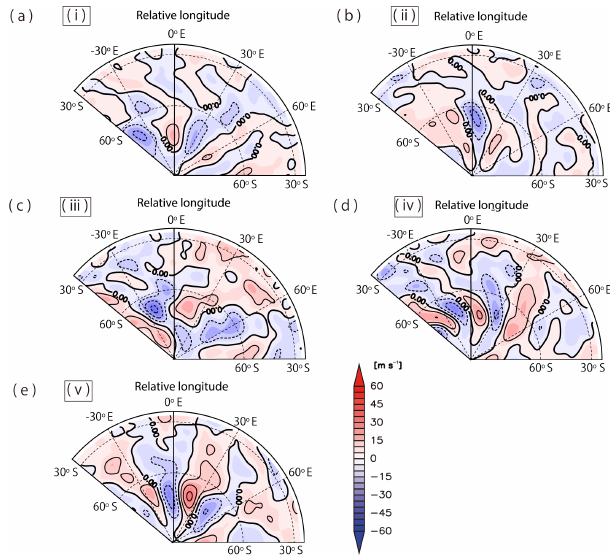
Figure 10. Composite maps of zonal wind components of the large-scale inertia–gravity waves simulated by NICAM. The height where the composites are taken is (a) 70km, (b) 70km, (c) 75km, (d) 65km and (e) 72km. The longitudinal location is depicted as the relative longitude from Syowa Station. The contour intervals are 10ms − 1